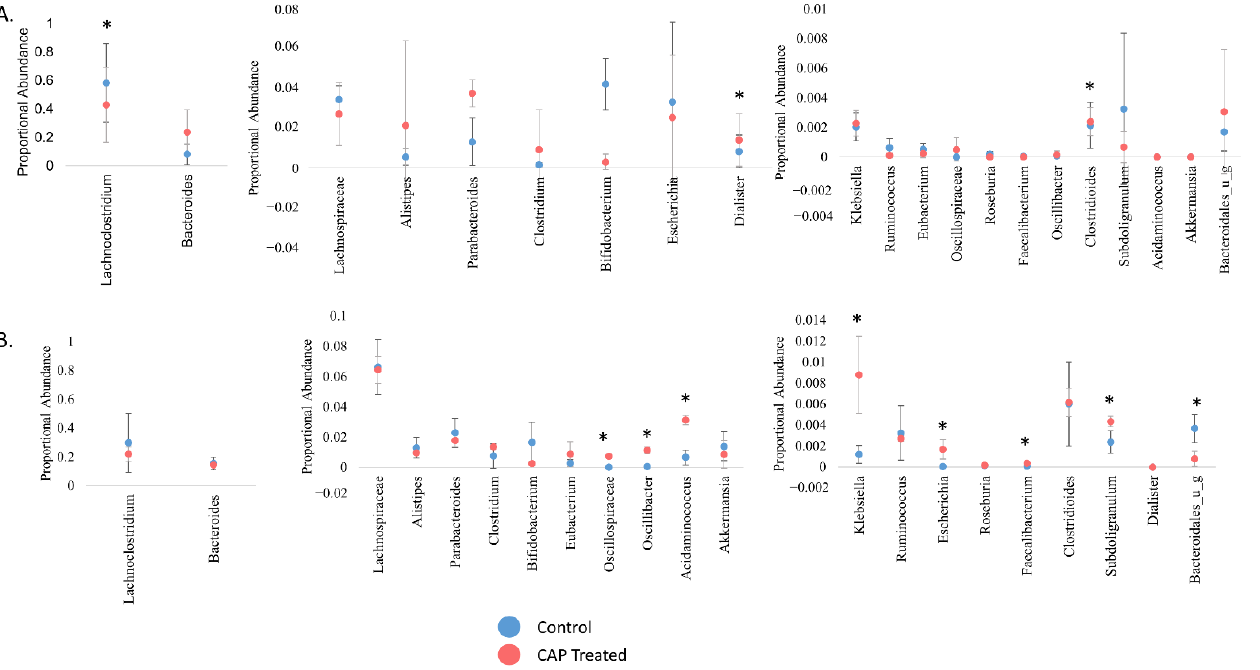
Figure 3. Proportional abundance of key gut microbiota, genus level. The proportional abundance in this instance references the abundance of a genus in comparison to others present at that time point. ( A ) C1, ( B ) C2. Significance was determined using a student’s t-test. * = p < 0.05.